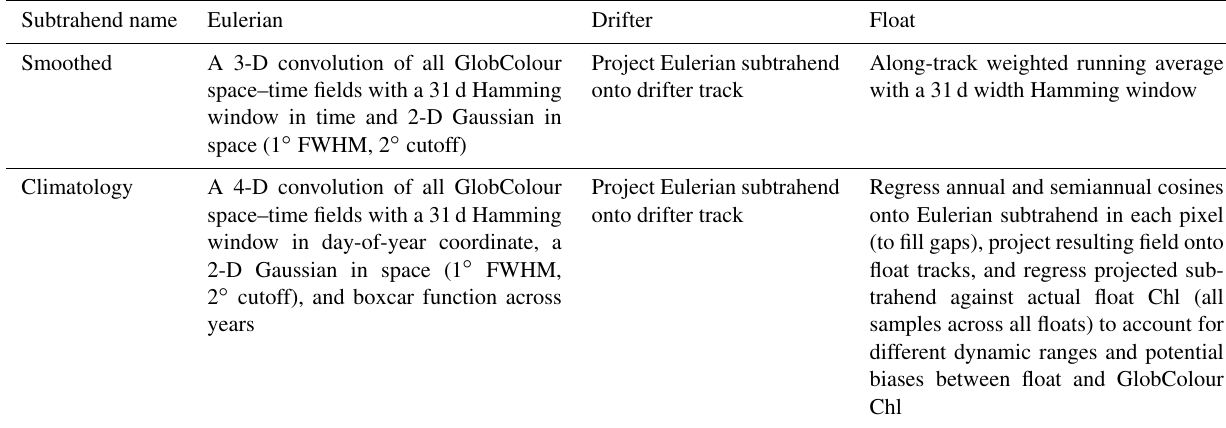
Table B1. Summary of